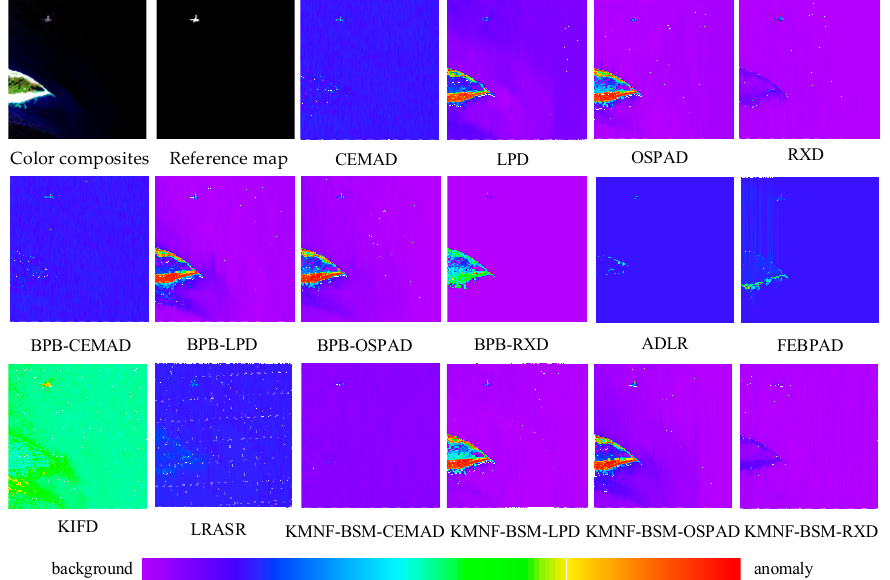
Figure 5. The detection maps of different detectors for the beach scene. The detection results of each method for the urban scene are shown in Figure 6. It The visual detection results of different methods for the beach scene are depicted in Figure 5. Similar to the results of the airport scene, LPD, OSPAD, BPB-LPD, BPB-OSPAD, BPB-RXD, KIFD, KMNF-BSM-LPD, and KMNF-BSM-OSPAD demonstrate poor back- ground suppression, generating high FARs. Compared with CEMAD, RXD, BPB- CEMAD, ADLR, FEBPAD, LRASR, and KMNF-BSM-RXD, the KMNF-BSM-CEMAD suc-